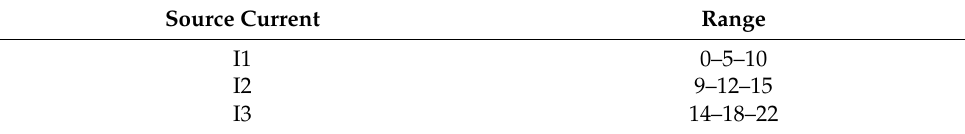
Table 1. Range of source current.